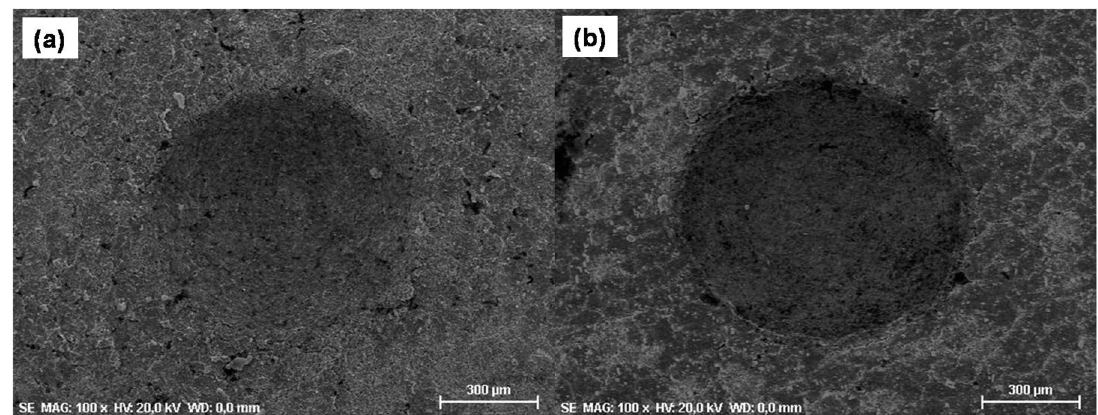
Figure 9. Rockwell indentation test of (a) 980 N (b) 1470